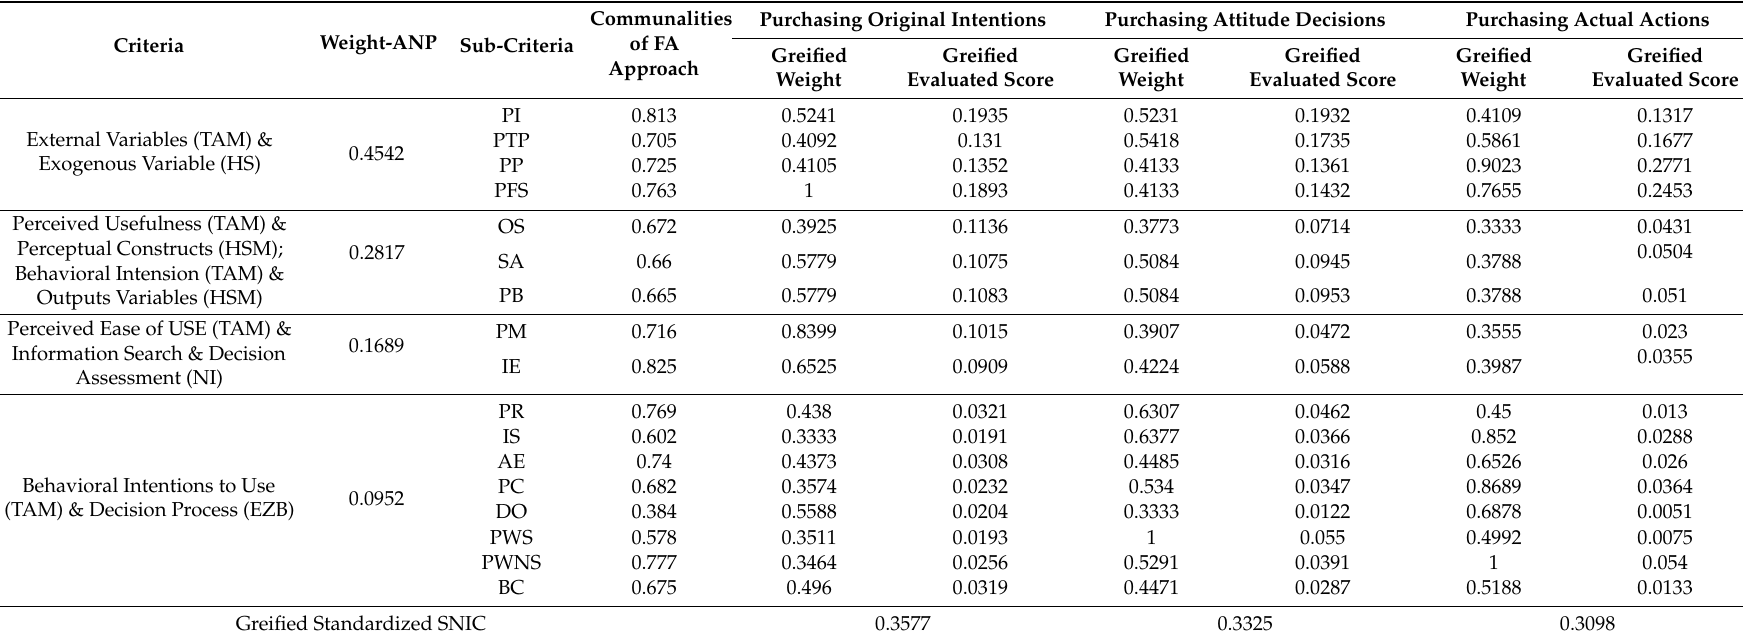
Table 8. The greified standardizing SCIN measurement of